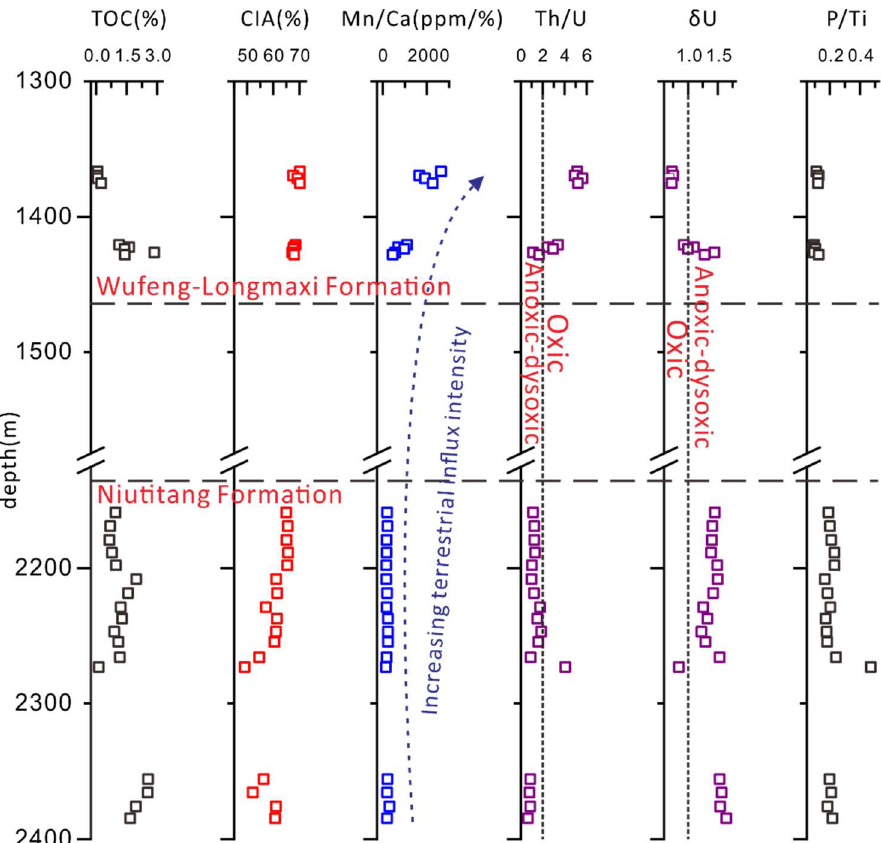
Figure 8. Trends of TOC content and paleodeposition-related inorganic geochemical parameters with depth.